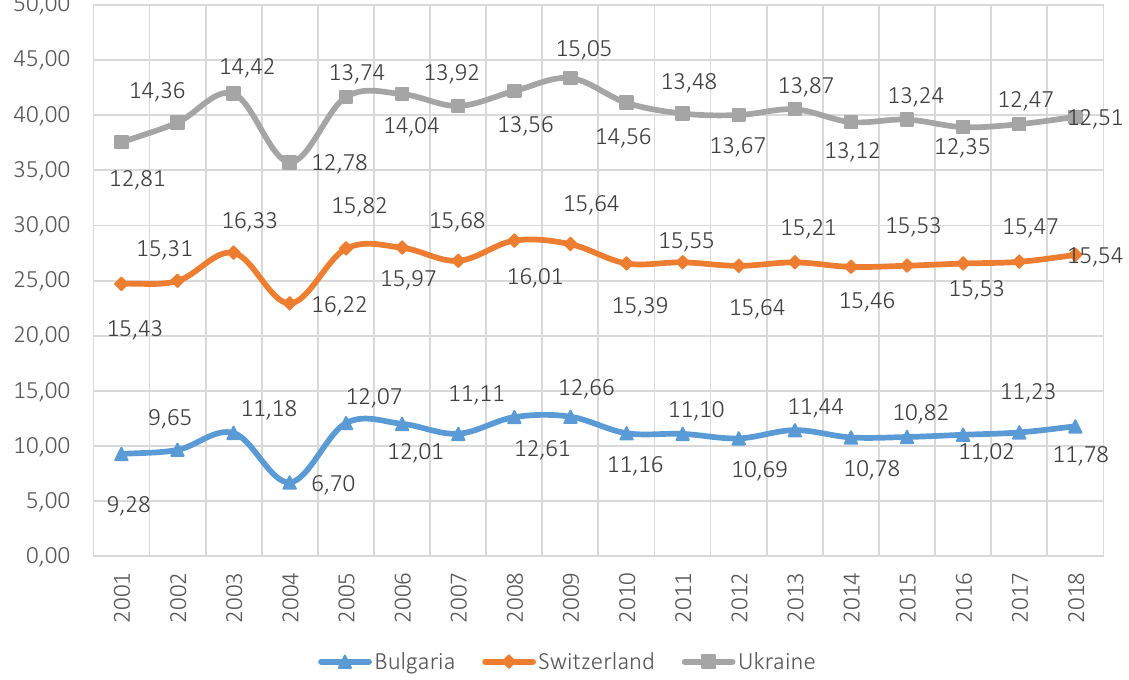
Figure 6. Government expenditure on education (total), % of government